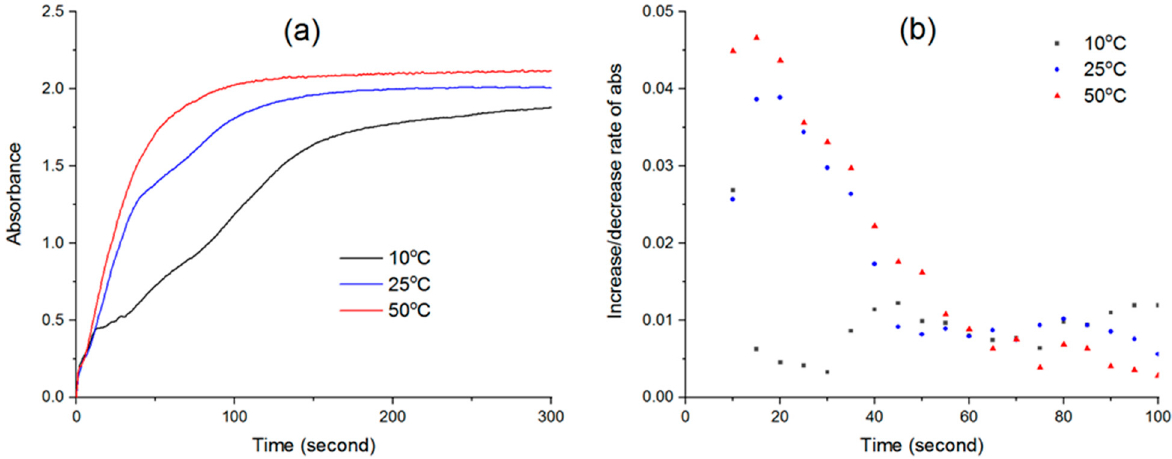
Figure 3. ( a ) UV absorbance over time of PVDF films immersed in water and ( b ) its increase rate.